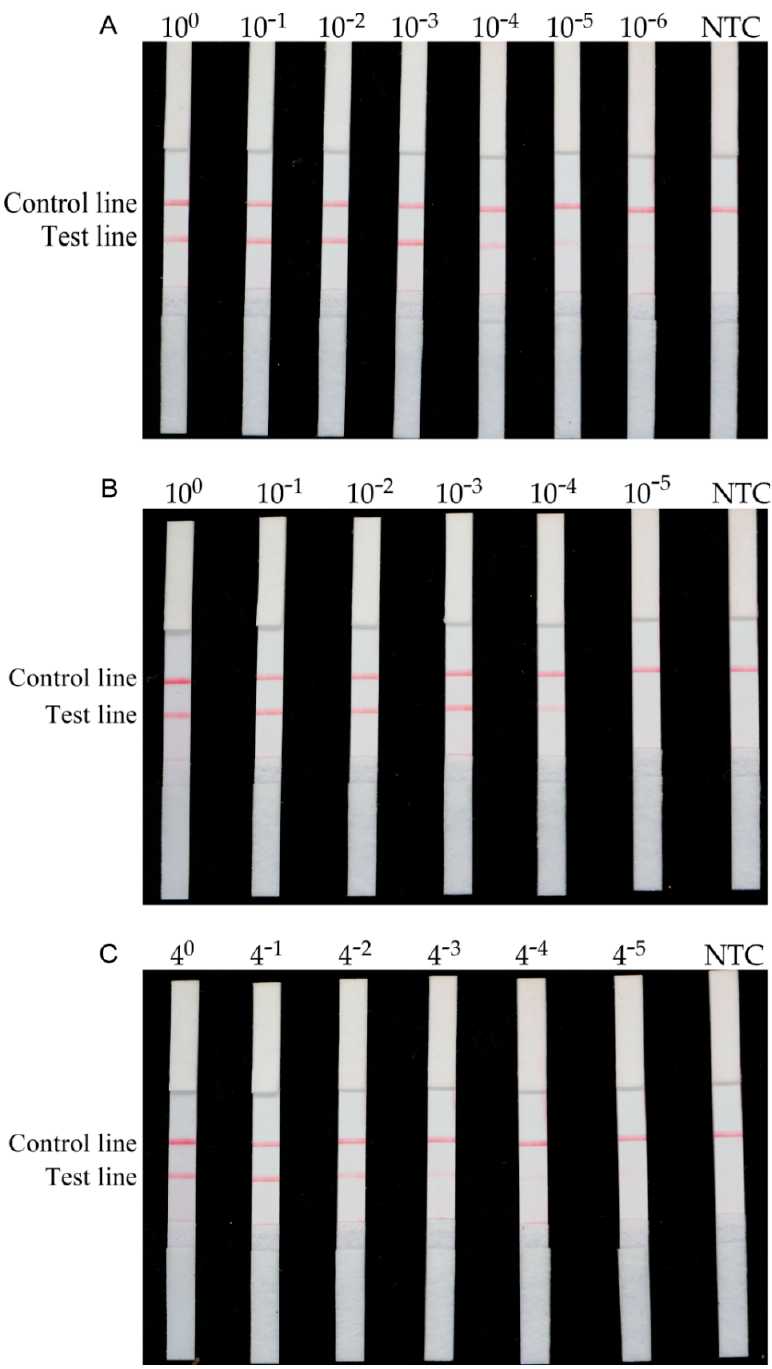
Figure 4. Molecular verification of sensitivity of the RPA system using gradient-diluted H. schachtii . ( A ) Gradient-diluted cyst sample. ( B ) Gradient-diluted female sample. ( C ) Gradient-diluted second- stage juvenile sample. NTC, no template was added as a negative control. The presence of two lines indicates a positive result.